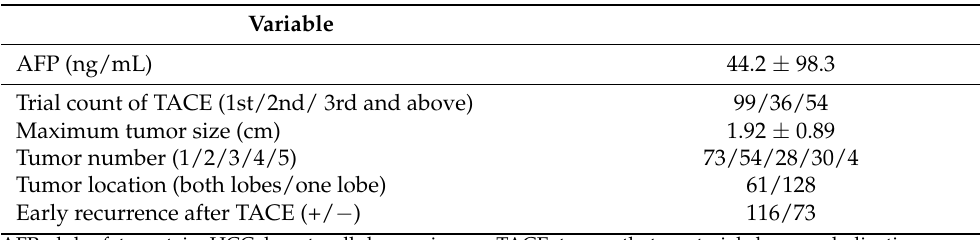
Table 2. Characteristics of HCC at the time of each